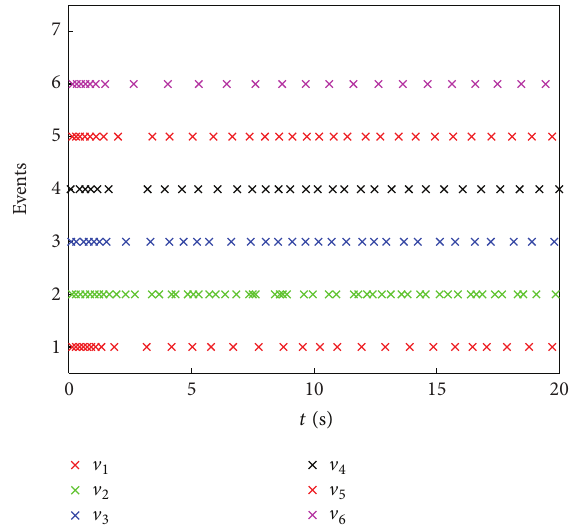
Figure 6: Event-triggering instants of the CMVWT vehicles.